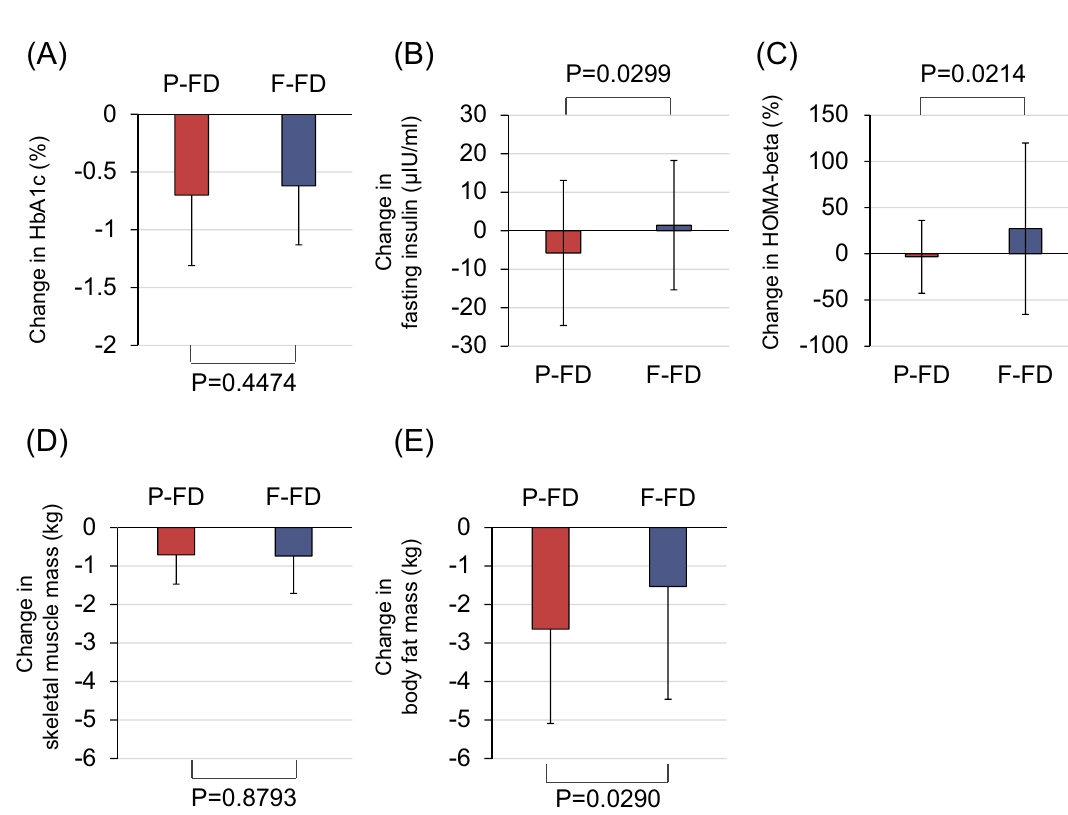
Figure 3. Changes in outcome measures in the group treated with dapagliflozin and protein-rich formula diet (P-FD) and the group treated with dapagliflozin and fat-rich formula diet (F-FD). ( A ) Change in HbA1c, ( B ) change in fasting insulin, ( C ) change in homeostasis model assessment of beta cell function (HOMA-beta), ( D ) change in skeletal muscle mass, ( E ) change in body fat mass. Data are presented as mean ±